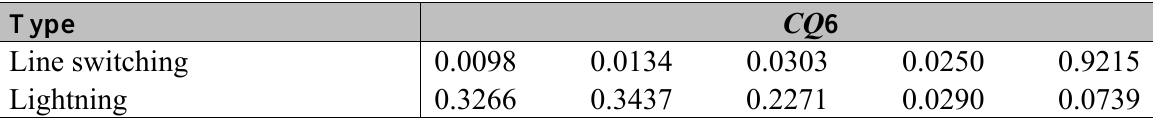
Table 2. The sixth characteristic